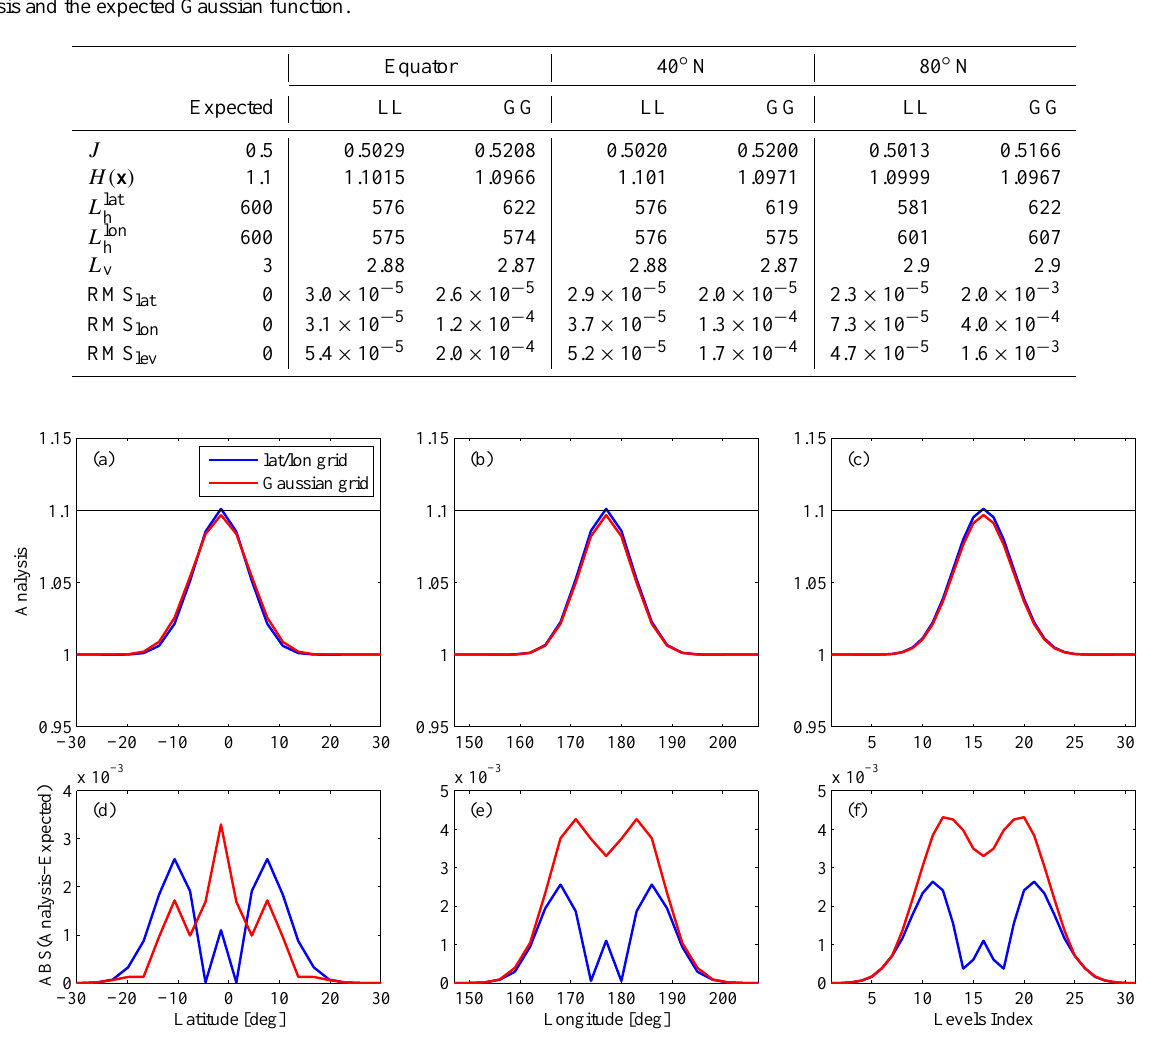
Table 1. Scores of the single-observation assimilations using two different target grids of the spectral transform: the model lat/lon grid (LL) and the Gaussian grid (GG). The experiments have been performed considering three latitudes of the observations: the Equator, 40 ◦ N and 80 ◦ N. We report the value of the objective function J for the analysis, the analysis at the observation location H( x ) , the analysis correlation length scales obtained by fitting the analysis cross-sections (see Fig. 1) by a Gaussian function, and the root mean square (RMS) between the analysis and the expected Gaussian function.